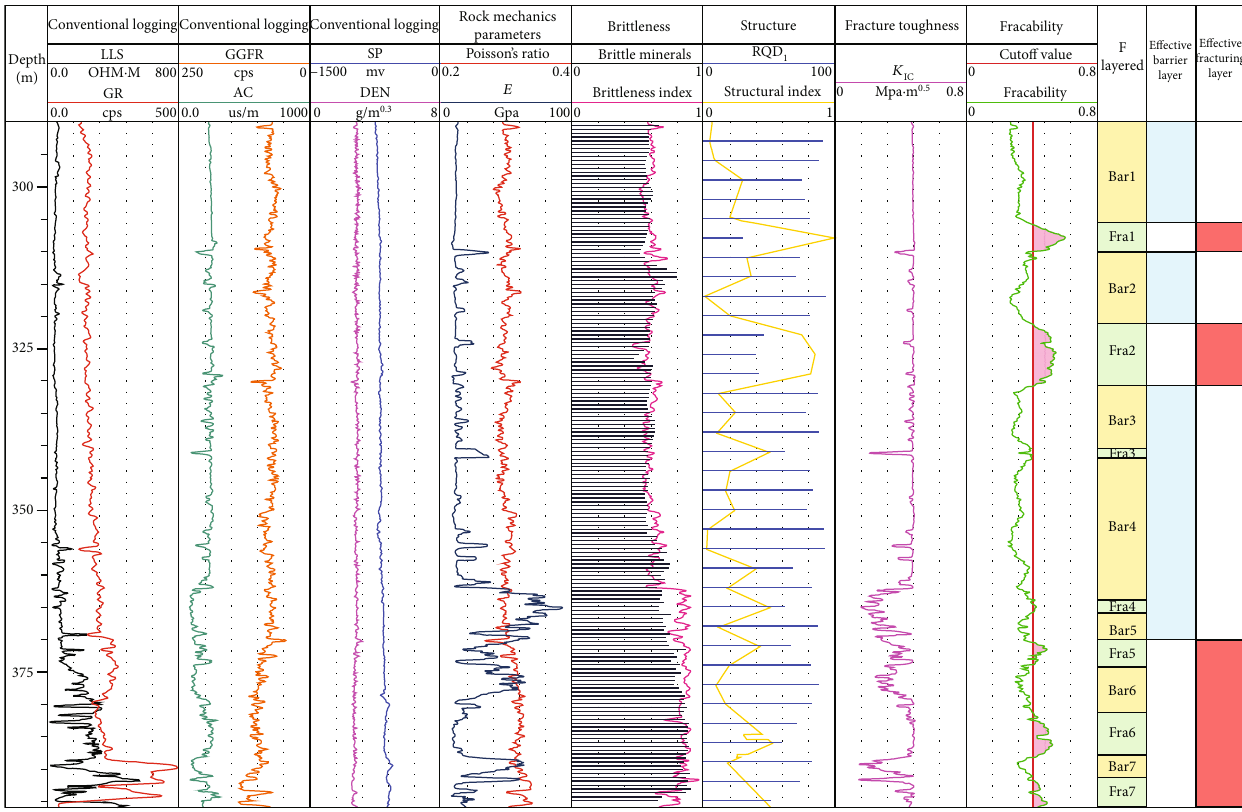
Figure 12: Screening hydraulic fracturing candidates with a fracability index (Xike 2).